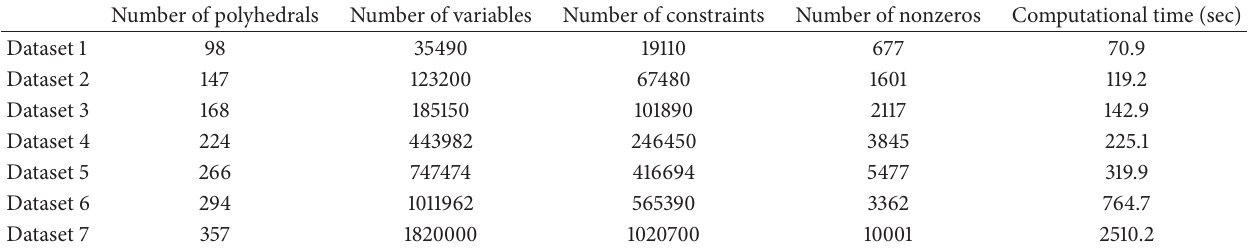
Table 2: Sizes and computational results for some MMNs with |𝐾| = 7 ( 𝑇 = 13, 20, 23, 31,37, 41, 50 ).